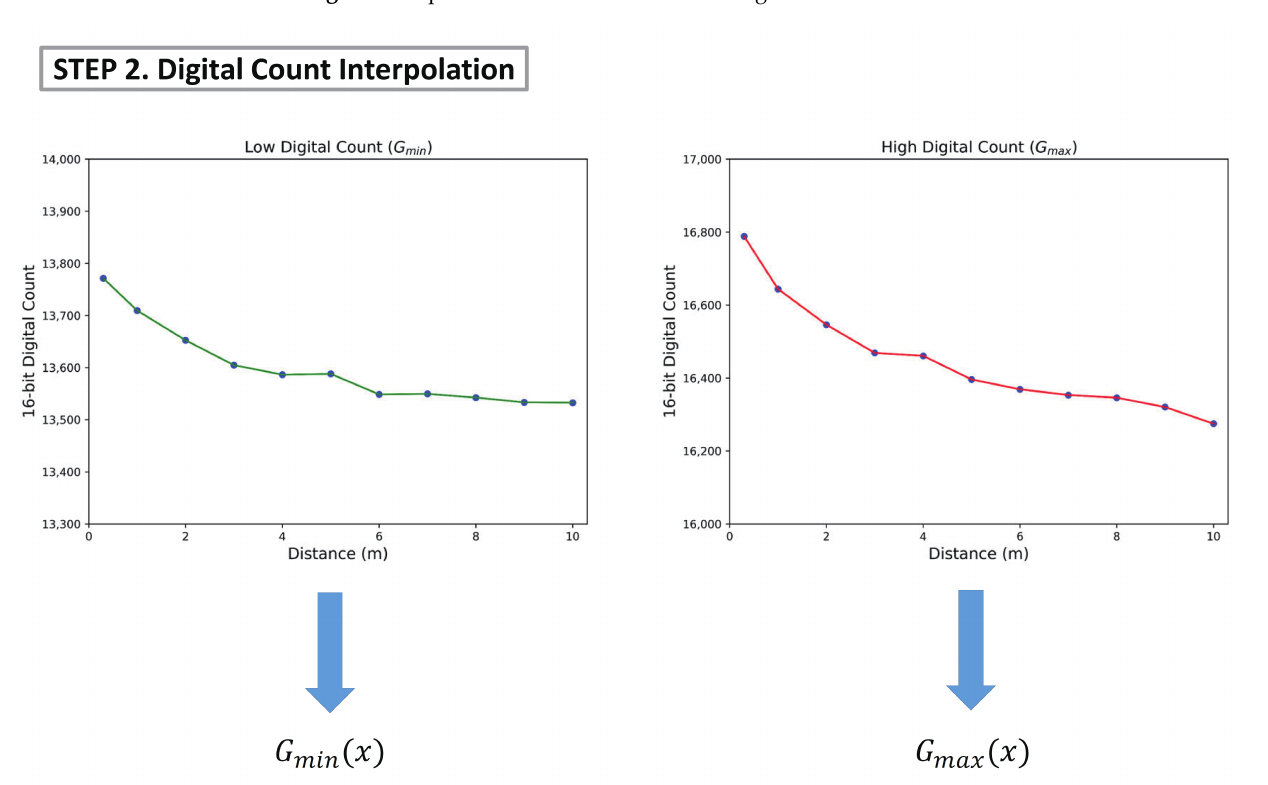
Figure 8. [STEP 2: Digital Count Interpolation] Interpolation function is obtained through G min and G max by